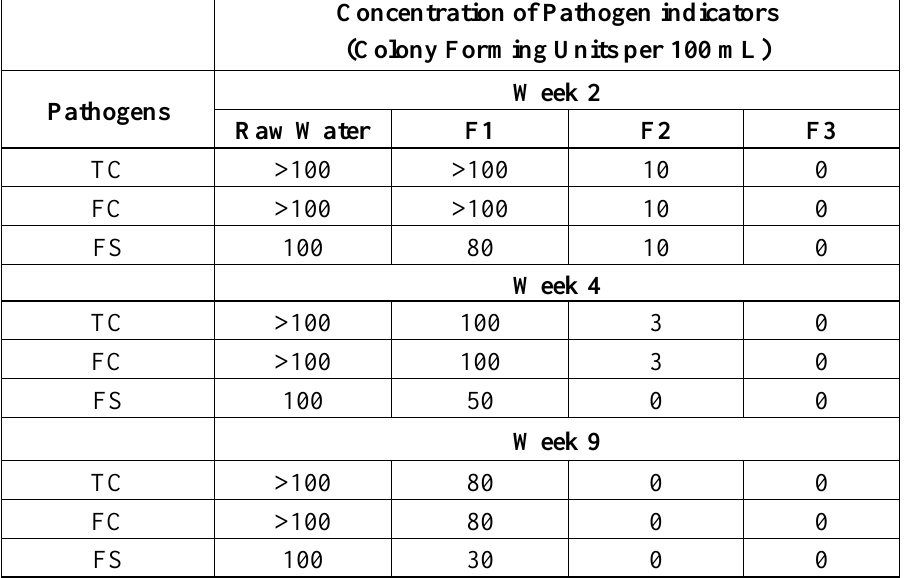
Table 2. Concentration of pathogen indicators measured from water samples collected during the course of filter